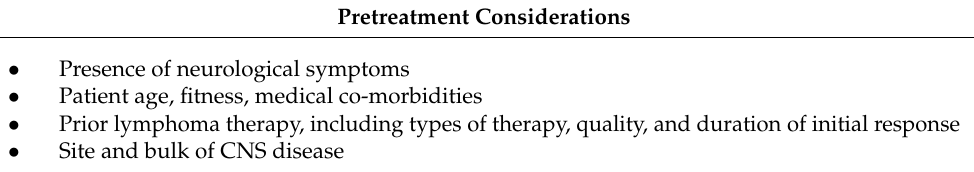
Table 4. Pretreatment considerations in the management of Bing – Neel syndrome.